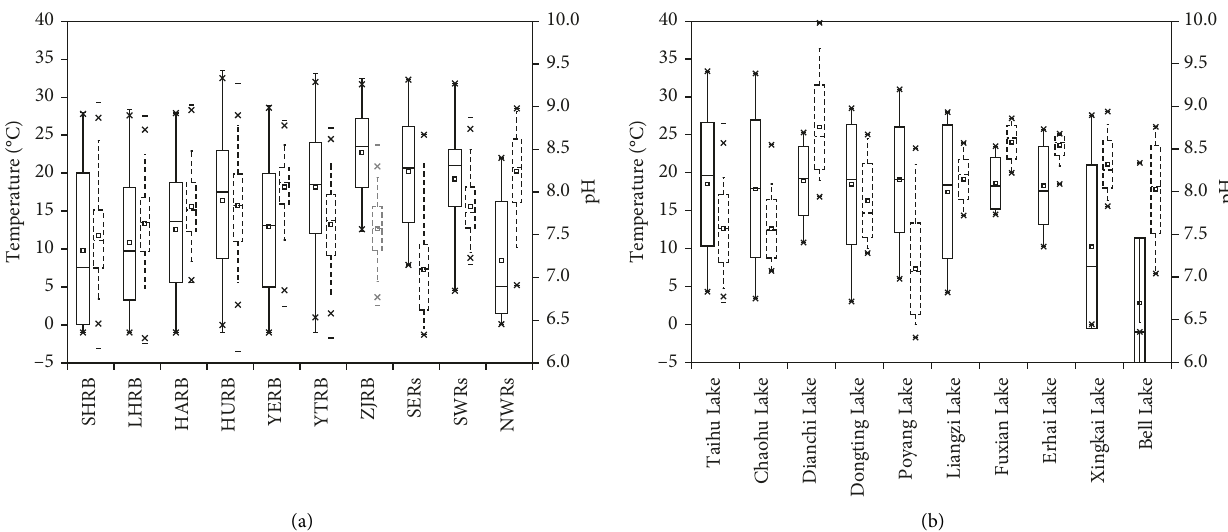
Figure 2: pH and temperature in twenty Chinese major basins in 2017. Dashed box indicates pH values, and solid box indicates temperature.